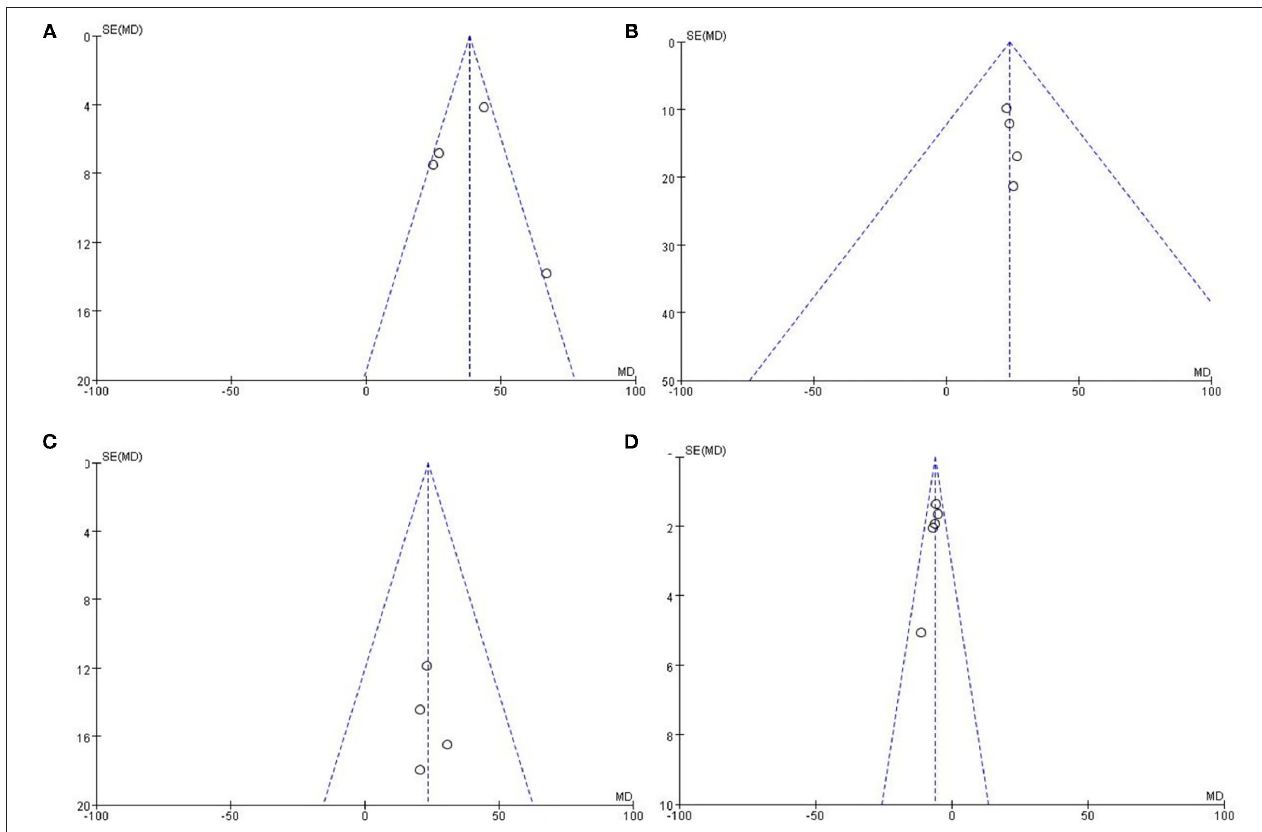
FIGURE 3 | Funnel plots for the meta-analysis. (A) QRSd, (B) LVEDV, (C) LVESV, and (D)